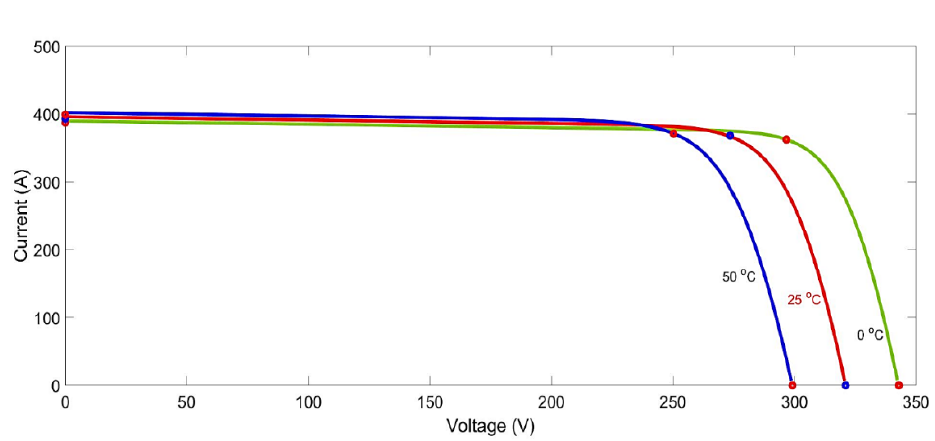
Figure 4. Current-voltage, photovoltaic module curves at different temperatures and permanent insolation levels.